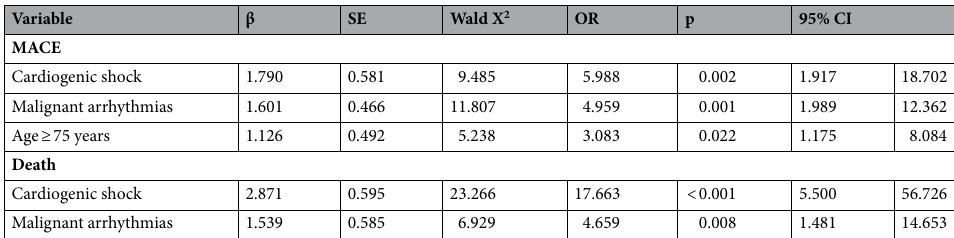
Table 3. Multivariate COX analysis for MACE and death in 3 months after PCI. Variables in adjusted model were age (≥ 75), gender, BMI (≥ 30), smoking, DTB, operation time, hospital stay, DES (drug eluting stent), IABP use, final TIMI-3, diabetes, hypertension, hyperlipidemia, Takotsubo syndrome, cardiogenic shock, malignant arrhythmias, heart failure and grouping (2019 group vs COVID-19